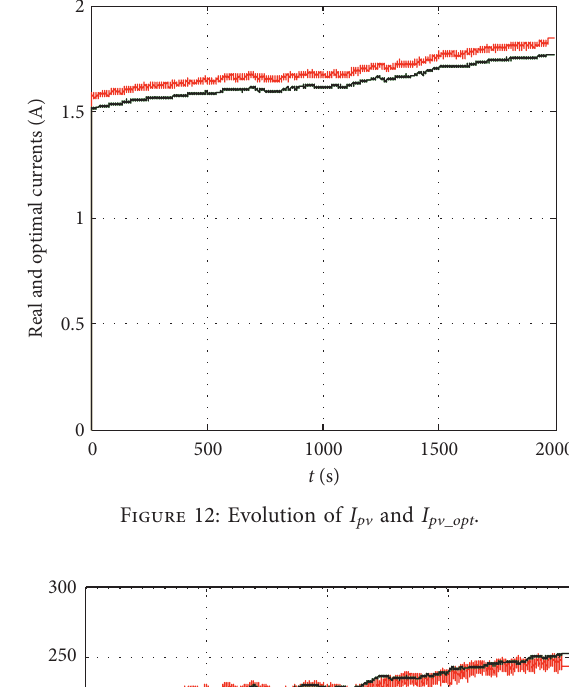
pv and I pv_opt .